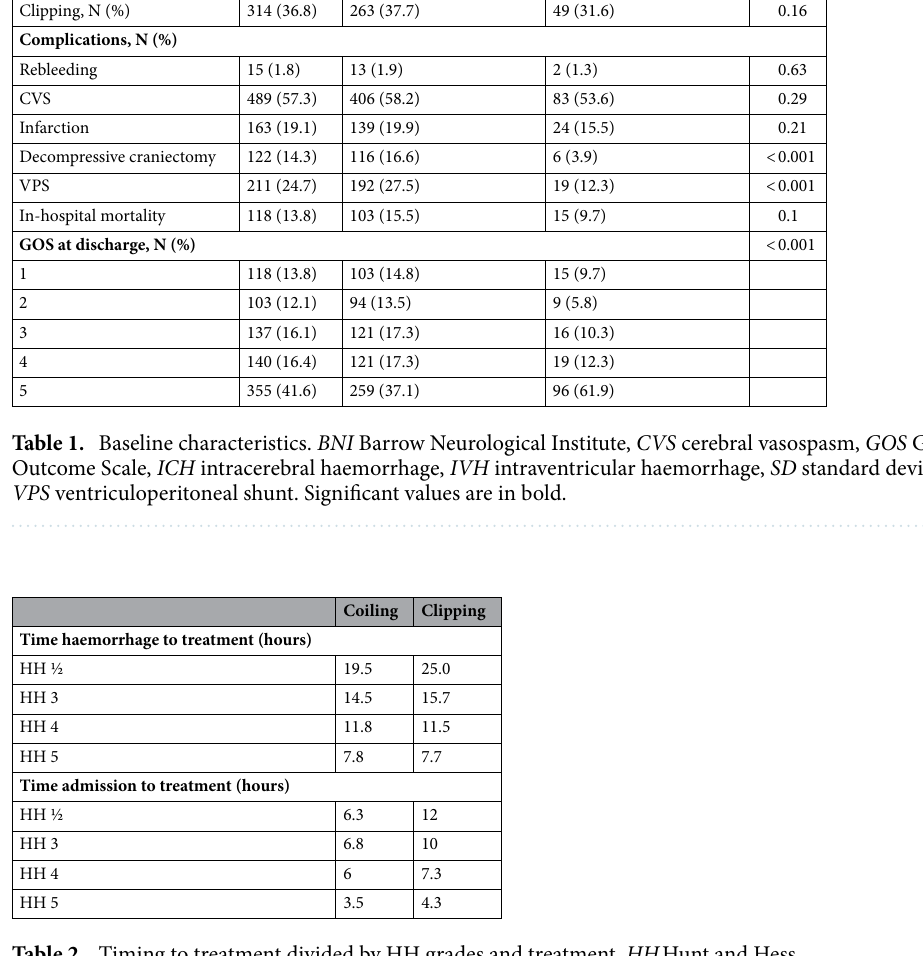
Table 2. Timing to treatment divided by HH grades and treatment. HH Hunt and